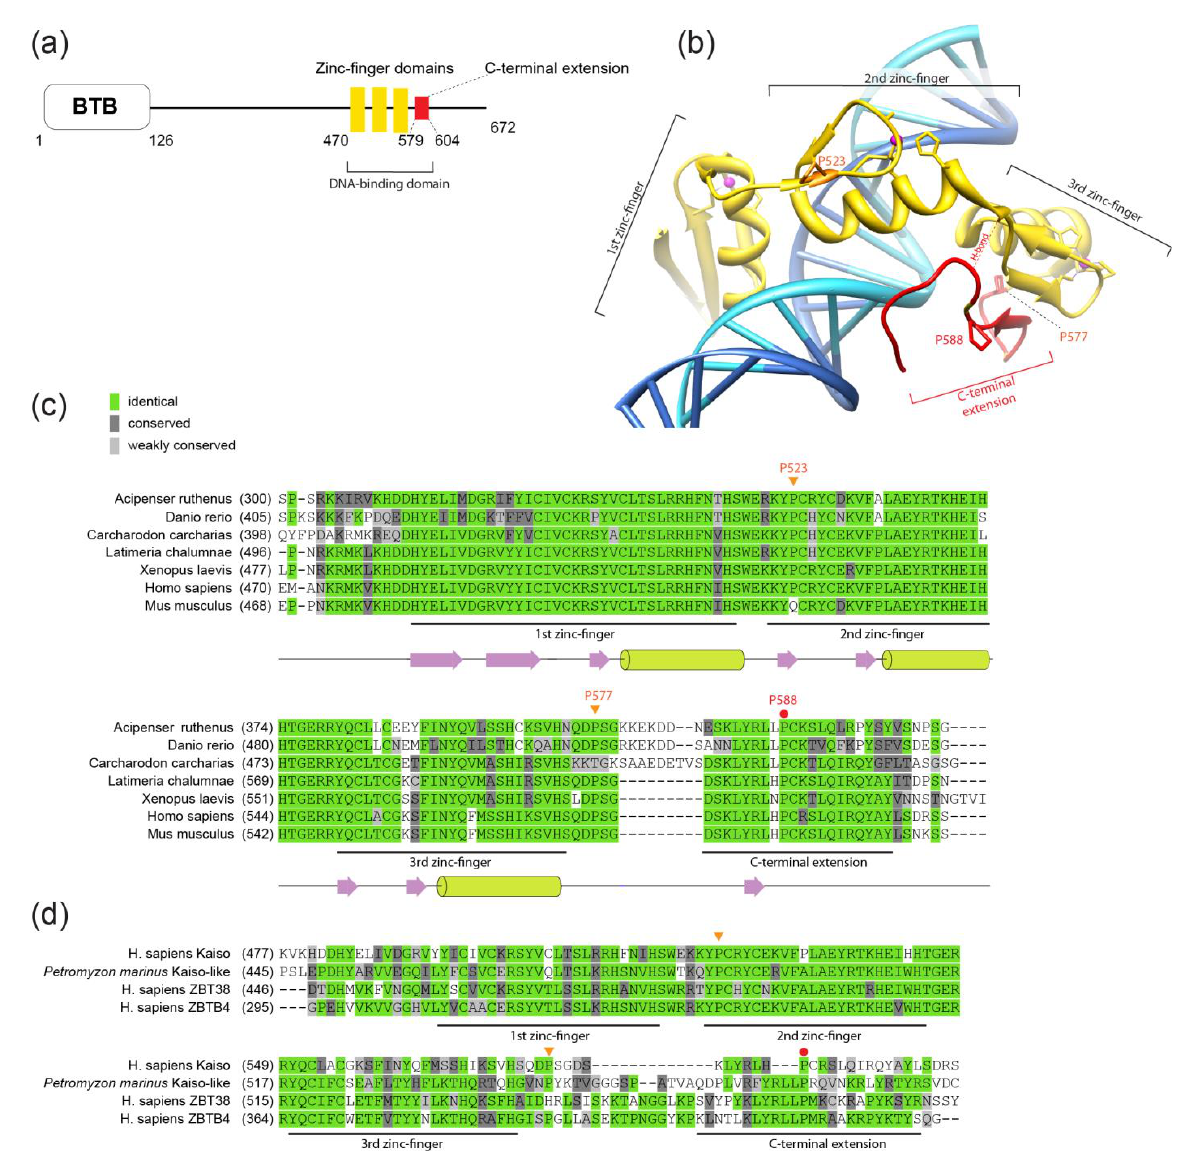
Figure 1. ( a ) Schematic representation of Kaiso domain structure, with the protein regions involved in DNA binding indicated. ( b ) Structure of Kaiso – DNA complex (PDB:4f6n [15]). ( c ) Multiple sequence alignment of the DNA-binding domains of Kaiso proteins from different vertebrates. P588 is indicated with a red circle, and P523 and P577 are indicated with orange triangles. ( d ) Multiple sequence alignment of DNA-binding domains from human Kaiso, ZBTB4, and ZBTB38 proteins and the Kaiso-like protein from the most ancient living vertebrate, Petromyzon marinus (lamprey). Molecular graphics were prepared using UCSF Chimera [30] . Multiple sequence alignments were